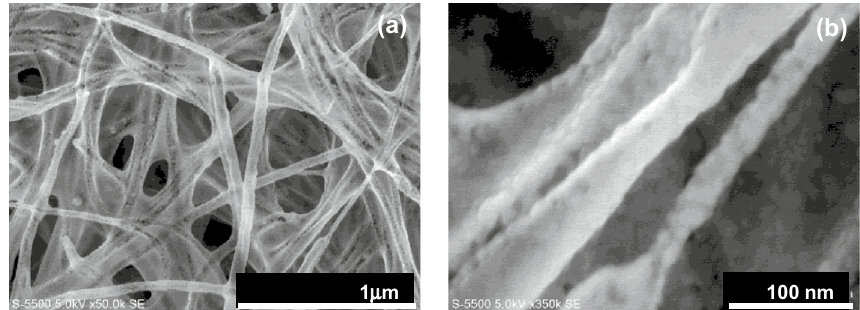
Fig. 1 a FE-SEM image of porous C-doped TiO 2 film annealed at 550 °C. b FE-SEM image of the agglomerated particles forming the open shell TiO 2